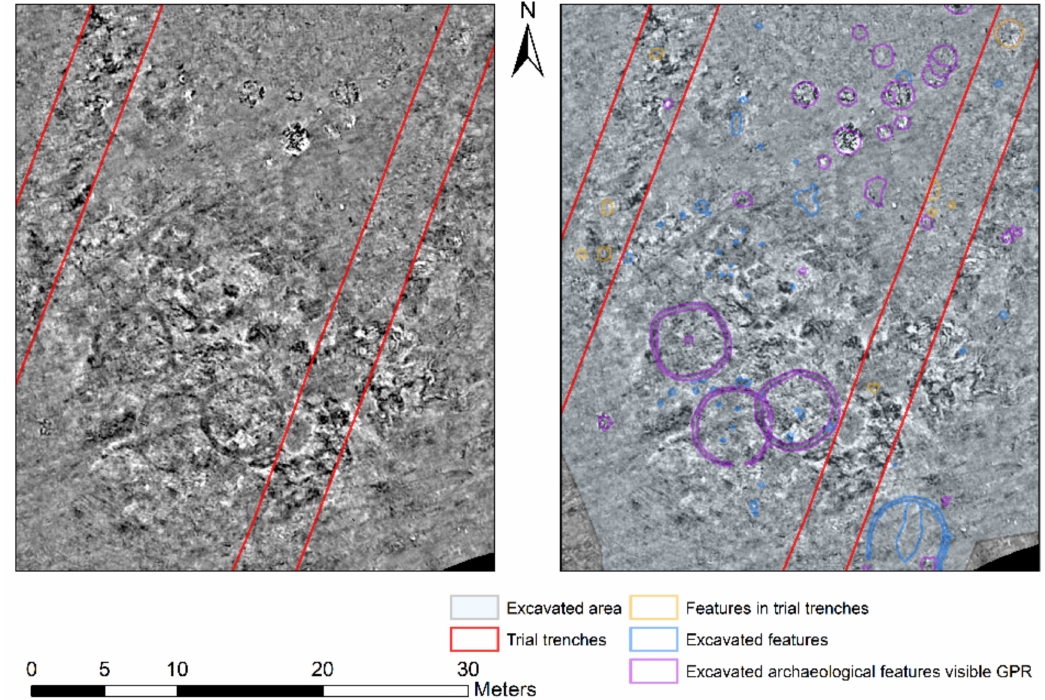
Figure6. AnexampleofaGPRdepthslicefromØyacomparedwiththelocationoftrialtrenches, features identified by trial trenching excavated features, and the excavated features visible in the